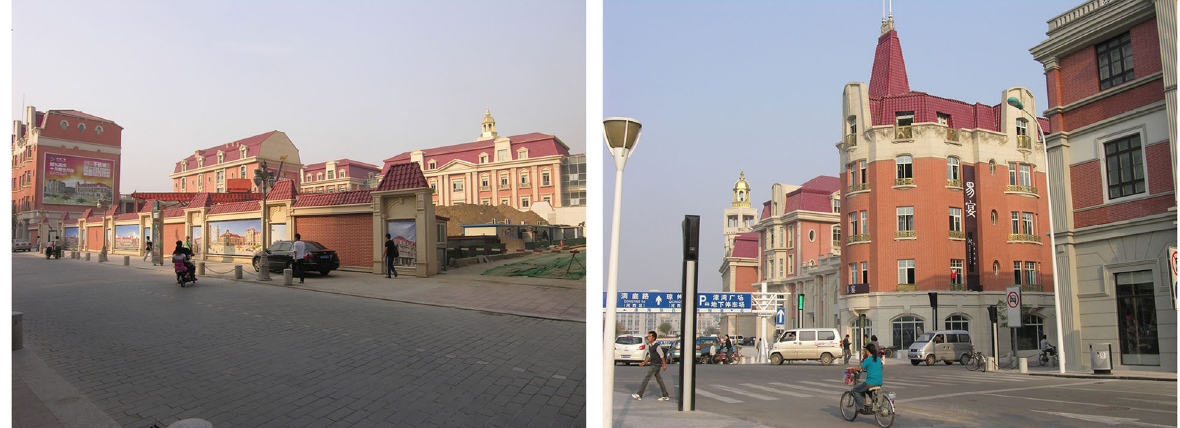
Fig. 7 A ‘ protected building ’ (Belfrand) in the former French Concession of Tianjin. Left: the advertisement by the real estate developer on the construction site fence, 2010. Right: the actual building after completion a few years later, 2018 (Source: Bruno